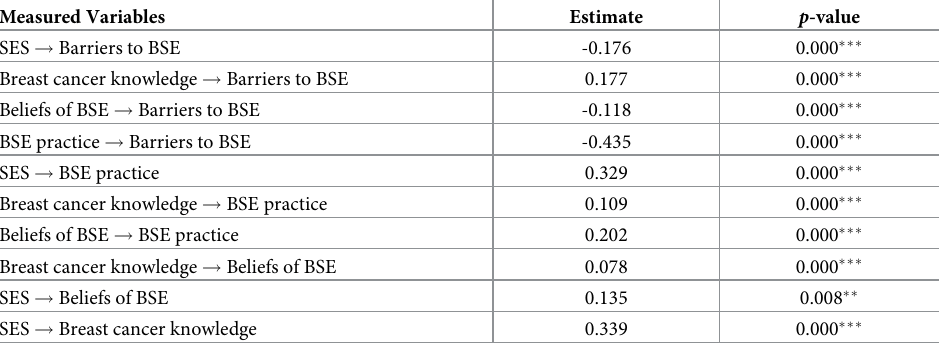
Table 5. Standardized regression weights of